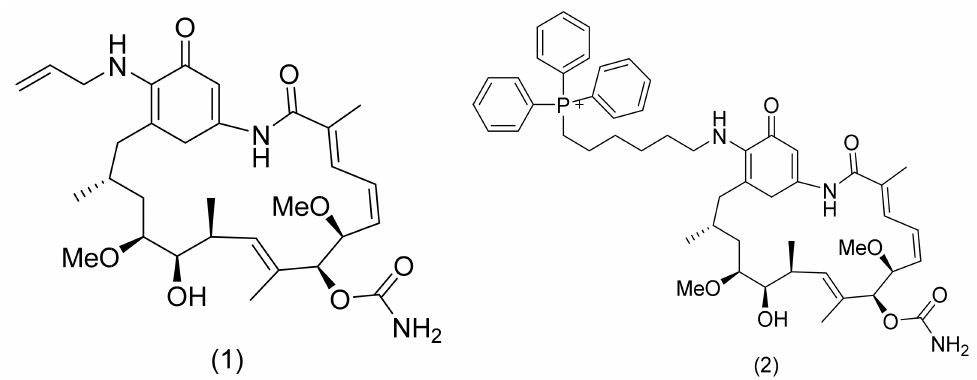
Figure 1. The 2D representation of 1 Tanespimycin and 2